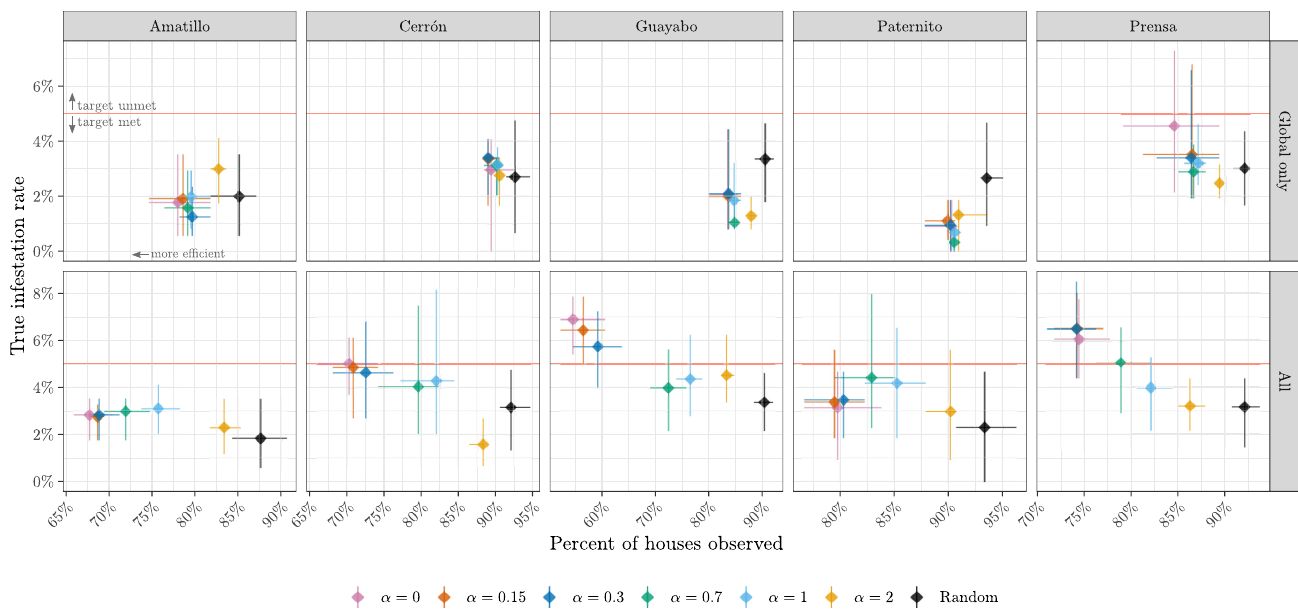
Fig 3. Results from the simulation experiment for each village and predictor set. The adaptive sampling procedure for varying α , along with random sampling, is performed for 50 initial sets of 10 houses. The x-axis is the percentage of houses in the final sampling design, and the y-axis is the true infestation rate remaining in the village. Diamonds show means, while cross-hairs show the 90% confidence intervals of the data corresponding to each axis. The red line indicates the 5% reduction target.